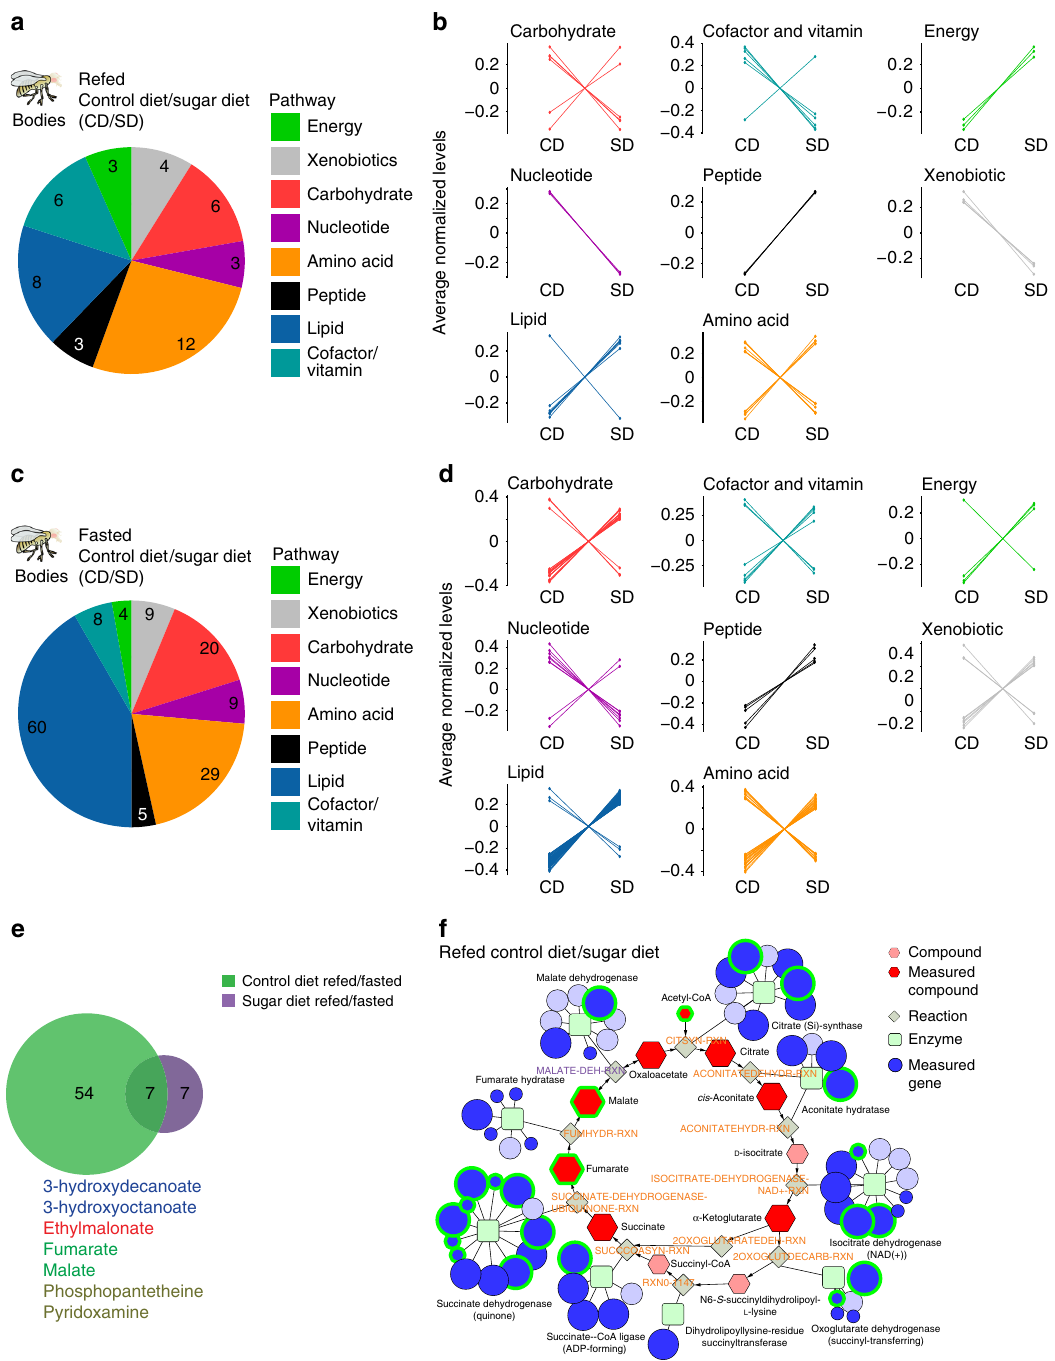
Fig. 4 Consumption of a SD alters the metabolic pro fi les of fasted and refed fl ies. a , b The effect of a high sugar diet on the metabolite classes (labeled by different colors) in the bodies of a , b refed and c , d fasted fl ies. Control diet (CD) and high sugar diet (SD). Welch ’ s t -test, FDR < 0.1. b , d The normalized levels of the compounds, grouped by class, that differ between b the refed CD and SD fl y bodies (45 compounds), and d the fasted CD and SD fl y bodies (144 compounds). Color scheme de fi nes metabolite classes listed in a . e Venn diagram showing the overlap in the metabolic compounds that change between the refed and fasted conditions in the bodies of fl ies fed a CD (green shade) or SD (purple shade). Metabolites shared between fl ies on a CD and SD are listed and colored according to class as in color scheme from a . f A Flyscape network made by using compounds changed in bodies of refed fl ies fed a CD or SD (panels a and b in this fi gure) and RNA sequencing generated by another study (see main text and methods). The size of the compound nodes (red hexagons) re fl ects changes in metabolite abundance (up or down) between refed and fasted fl ies, and salmon-colored hexagons represent compounds that were not measured. The size of the gene nodes (blue circles) represent the magnitude of change in RNA abundance between fasted and refed fl ies, (light blue circles are genes that were no measured). Green squares represent the enzyme. Compounds with an FDR < 0.1 by Welch ’ s t -test and genes with a corrected p -value < 0.05 by Wald test are outlined in green. Source data are provided as a Source Data fi